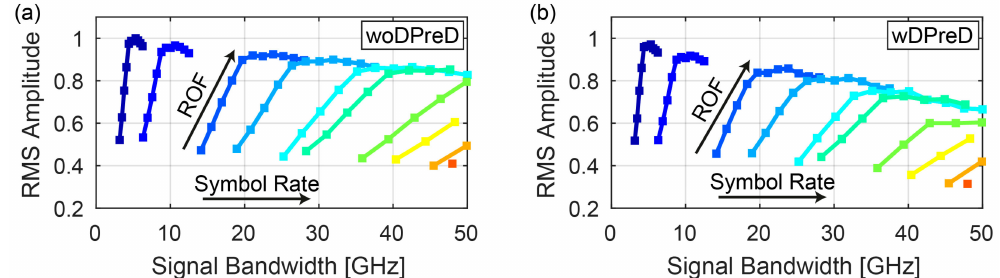
Figure 4. Electrical characterization of the influence of digital pre-distortion (DPreD) on the RMS amplitude of an SRRC signal generated with 100 GSa/s ( a ) without DPreD and ( b ) with DPreD. Both plots were linearly normalized to the same maximum value. The colors indicate the symbol rate (6.25, 12.5, 28, 37.5, 50, 56, 71, 80, 90, and 95 GBd). The signal bandwidth results from the symbol rate and the roll-off factor. woDPreD: without digital pre-distortion; wDPreD: with digital